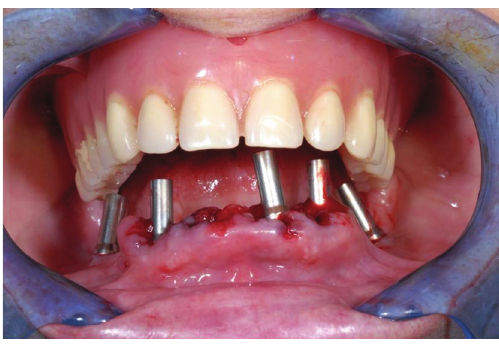
Figure 5: Abutments screwed to